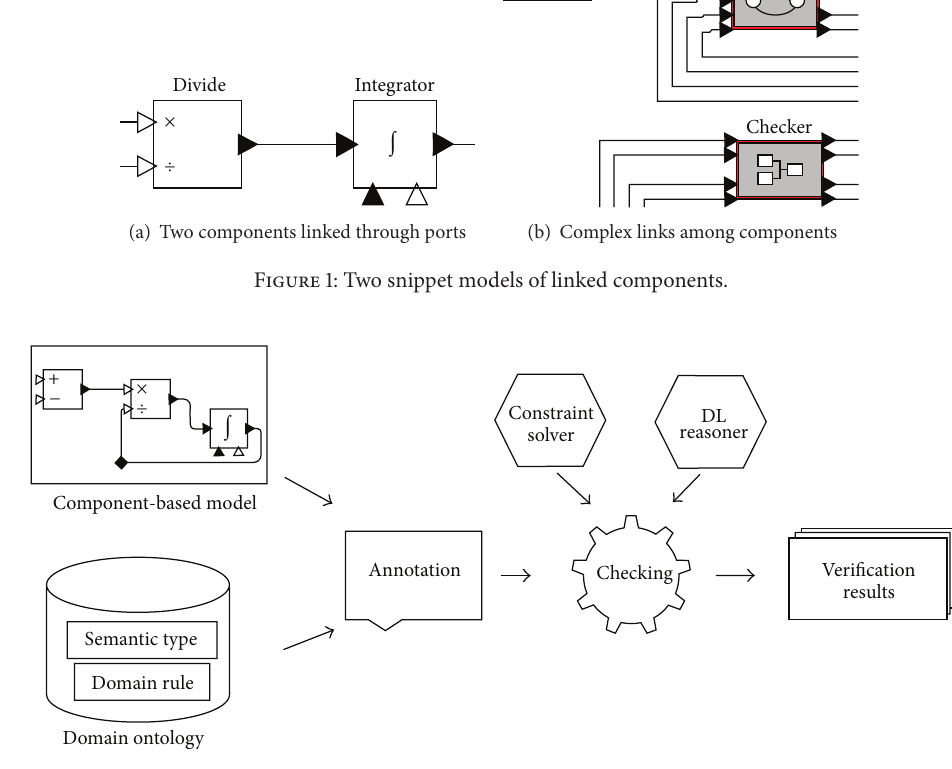
Figure 2: The overall framework of